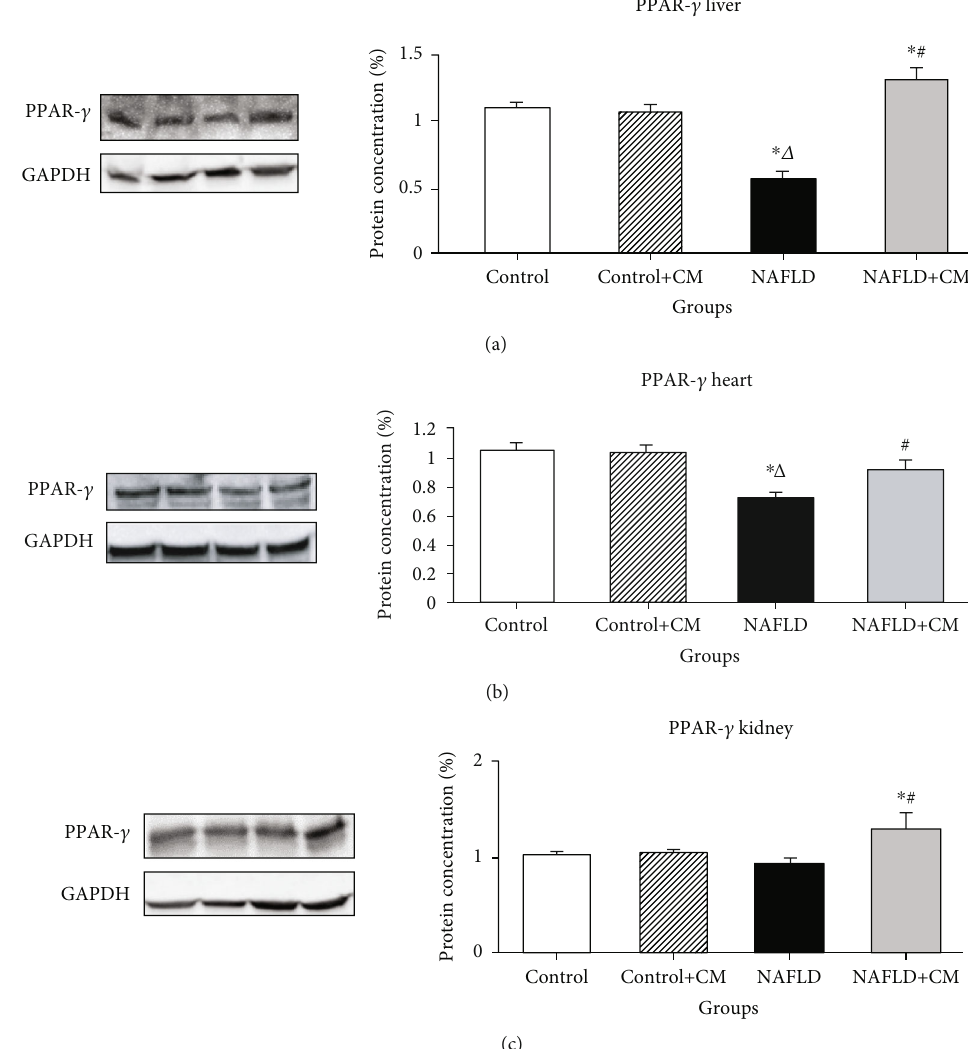
Figure 2: PPAR- γ protein expression in the liver (a), heart (b), and kidney (c) tissues of the control, camel milk (CM) treated control (control+CM), nonalcoholic fatty liver disease (NAFLD), and CM-treated NAFLD (NAFLD+CM) animals. The protein bands were quanti fi ed relative to GAPDH. ∗ p < 0 : 05 versus the control group, Δ p < 0 : 05 versus the control+CM group, and # p < 0 : 05 versus the NAFLD